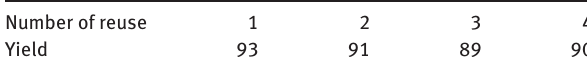
Table 2: Reusability of Amberlyst A-26 OH on the aldol condensa- tion of citral and